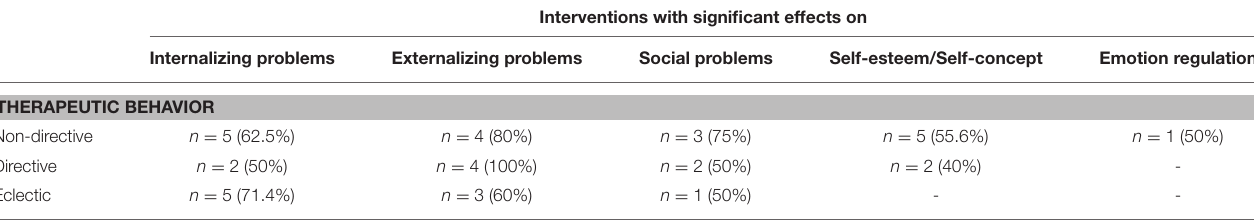
TABLE 3 | Number and percentage of interventions per type of therapist behavior showing significant effects on